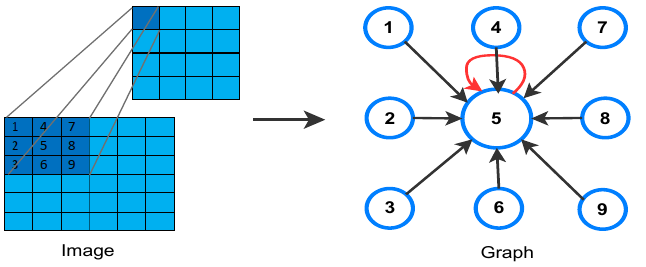
Figure 1. Convolutional operational strategies for regular grid structures and irregular graph